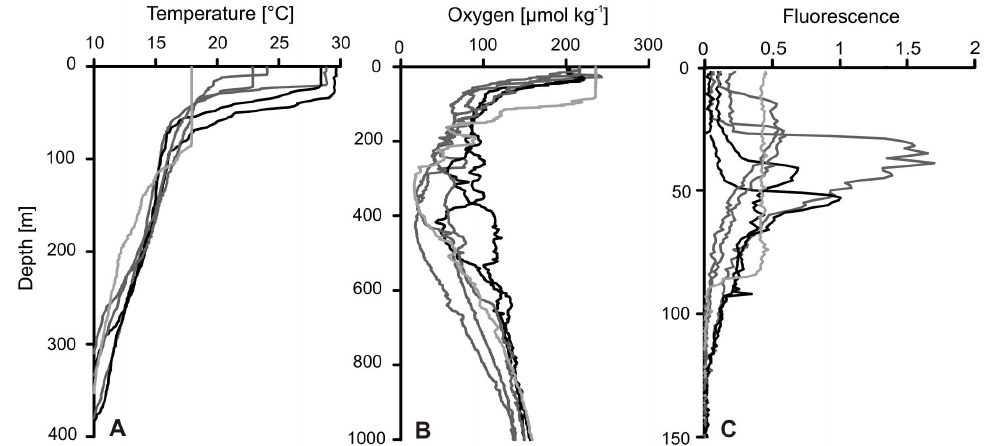
Figure 3. CTD profiles from stations analysed for copepod abundance. A, temperature. B, dissolved oxygen concentration. C, fluorescence (in relative units as proxy for chlorophyll a concentration). Shades of gray correspond to different station groups (SG1, 3, and 4) according to species composition derived from cluster analysis; SG1=black, SG3=dark gray, SG4=light gray. CTD data for SG2 were not available. Note the different scaling of the y-axes.